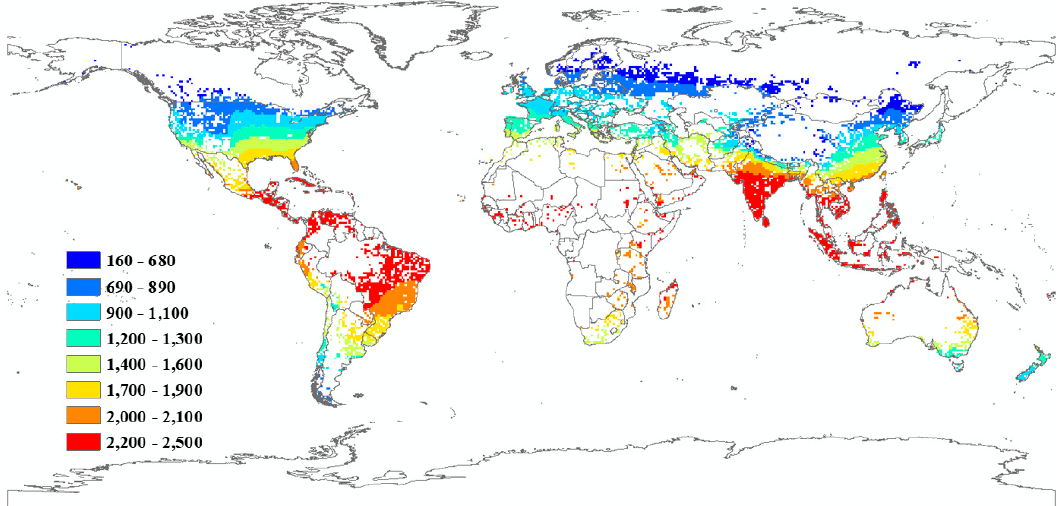
Figure 1. Map of the historical global net irrigation water requirement in 1960 of the area actually irrigated expressed as a percentage of the area equipped for irrigation in mm/yr.